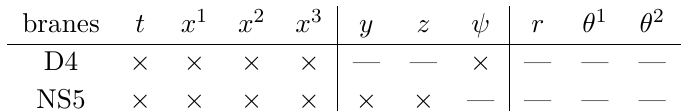
Table 2 . BPS/4 intersection describing the D4-NS5 bound state considered in section 2.1. The D4-branes extend along the ψ circular direction, along which the NS5-branes are located. The system supports a 4d N = 2 CFT